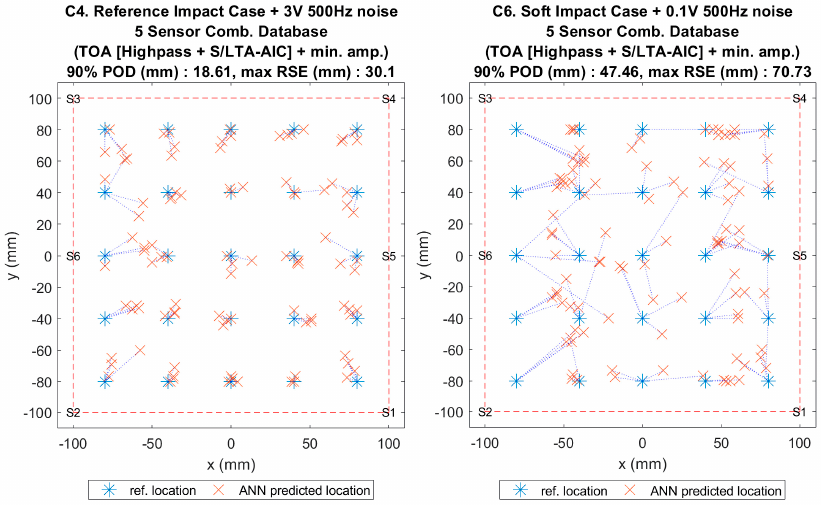
Figure 17. Visualisation of impact localisation for impacts with added noise for hard (C4, left) and soft (C6, right) impacts on the curved plate.